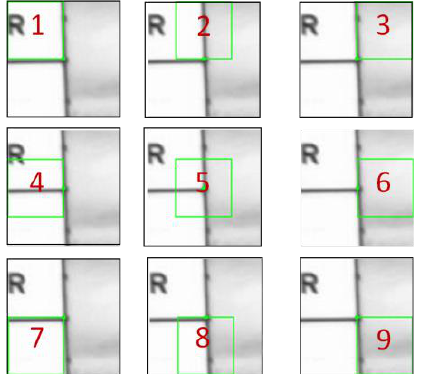
Figure 7. The 9 windows used for the proposed multi-window matching test.